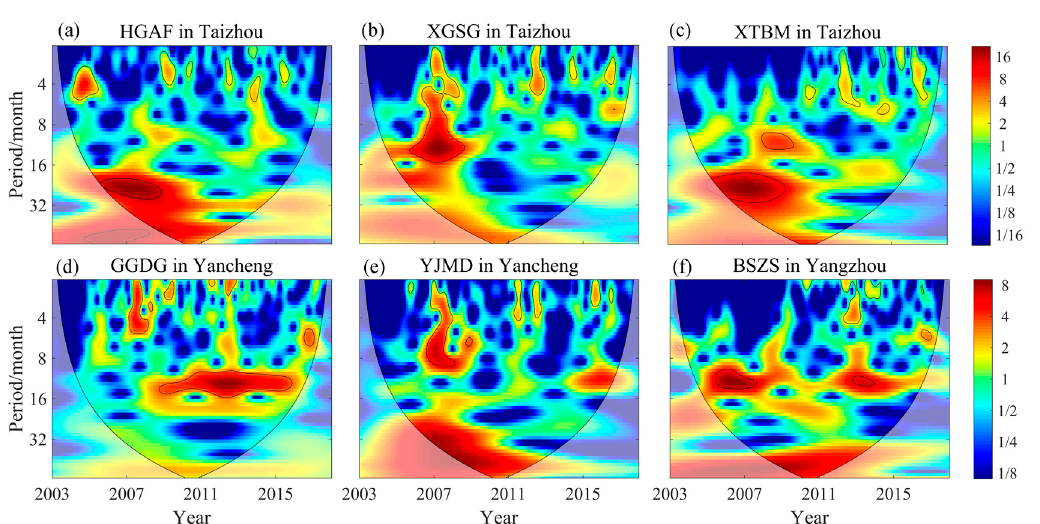
Figure 3. Results of continuous wavelet transform (CWT) of CWQI at six representative stations, ( a ) HGAF, ( b ) XGSG, ( c ) XTBM, ( d ) GGDG, ( e ) YJMD, ( f ) BSZS. Red and blue represent the peak and valley values of energy density respectively, and the color shade represents the relative strength of energy density. The closed area of the black thick solid line has passed the red noise test of the 95% confidence level. The cone area under the black thin solid line is the wavelet influence cone (COI), which indicates the area with great influence of data edge. Table 5. The characteristic periods of CWQI.